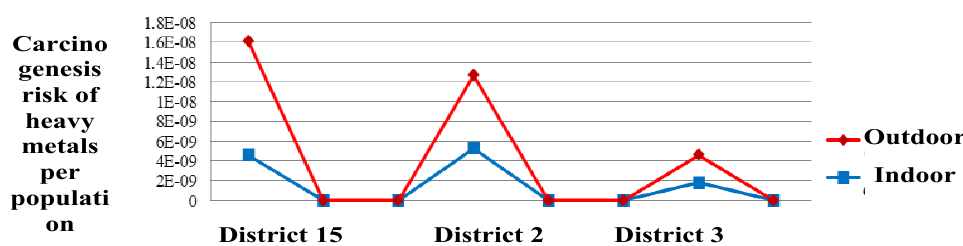
Figure 5. Carcinogenesis risk of heavy metals in outdoor/indoor spaces of high-traffic districts in Tehran, Winter 2018